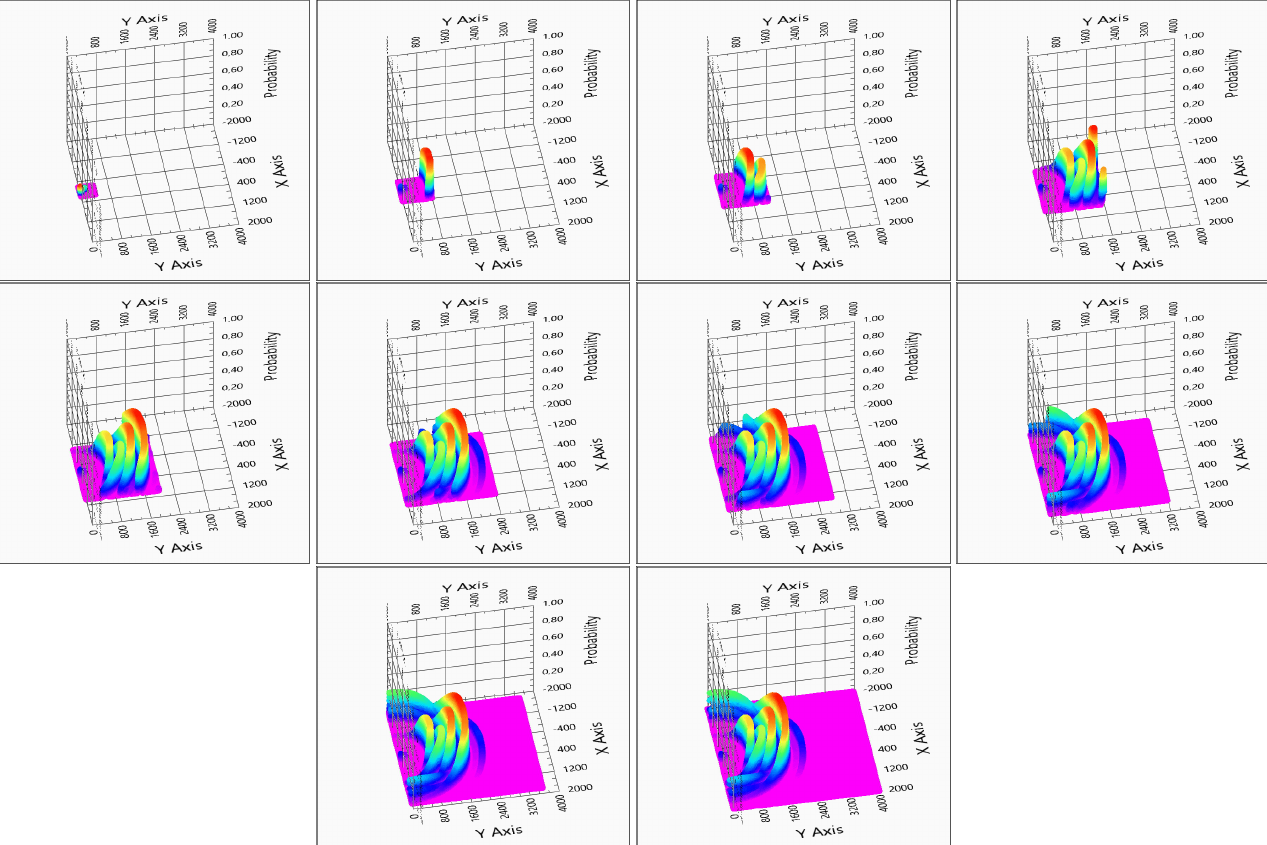
Figure 3. The resulting probability distributions of the occupation of the space with 3 sensors for the reference measurement. The different subplots correspond to the different number of evaluated points, i.e., the different size of evaluated area as listed in the first column of Table A1. The evaluated area varied from 401 by 401 to 4001 by 4001—the grid density did not